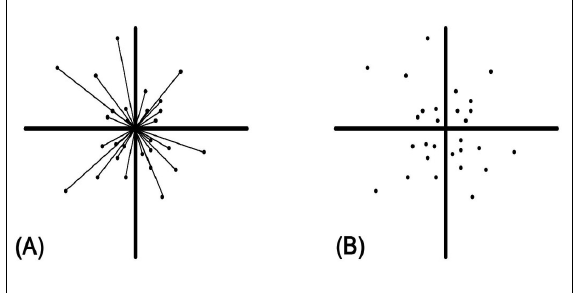
Figura 1. Representações bidimensionais para ilustrar o Mo- delo do Espaço Multidimensional. (A) é uma representação da codi fi cação Baseado na Norma. Cada ponto representa uma face previamente vista localizado no espaço n dimensional. A origem dos pontos representa o Protótipo. A similaridade entre duas faces é dada pela distância vetorial entre as faces. (B) é uma representação bidimensional ilustrativa do Modelo do Espaço Multidimensional baseado nos Exemplares. Assim como na Figura A, cada ponto representa uma face já vista localizada no espaço n dimensional. A origem dos pontos é arbitrária e representa a o ponto de maior densidade de faces. A similaridade entre as faces é determinada pela distância entre dois pontos e é independente do ponto de